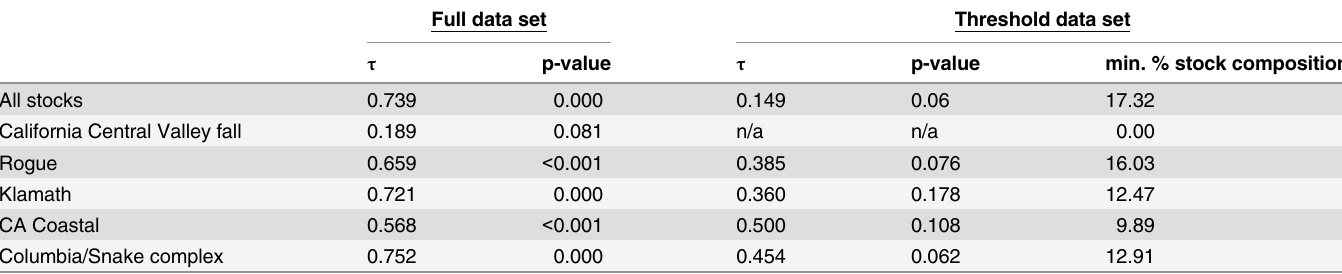
Table 7. Correlation analyses for paired genetic stock composition and stock-specific catch per unit effort (SSCPUE)